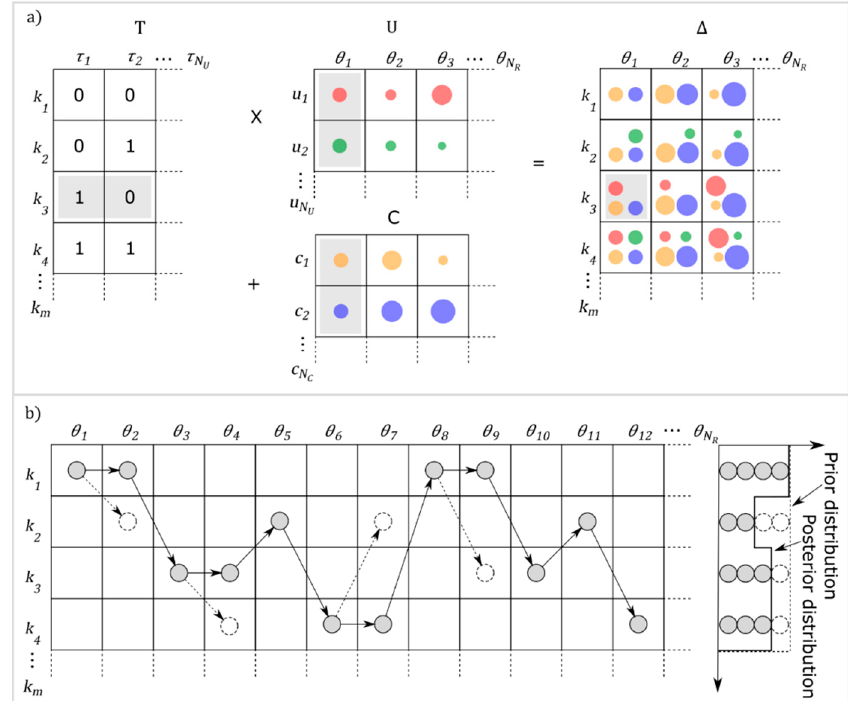
Figure 1. ( a ) Method for calculation of the water balance error, ∆ . The colours of the circles represent di ff erent system subcomponents, C, while the size of the circles represents the magnitude of the subcomponent in each realization, θ i with i ∈ { 1, ... , N R } where N R is the number of variable realizations. The combination of τ h with h ∈ { 1, ... , N U } , where N U is the number of uncertain model components, in the rows of T, constitutes a model, k j with j ∈ { 1, ... , m } where m = 2 N U . The uncertain model components in U includes N U components, while the certain model components in C includes N C components. ( b ) Metropolis–Hastings sampling of the water balance realizations. The circles and arrows represent those that are accepted or rejected based on the acceptance criteria, α . The dotted circles and arrows represent proposed moves that were not accepted. Figure 1b modified from [38].